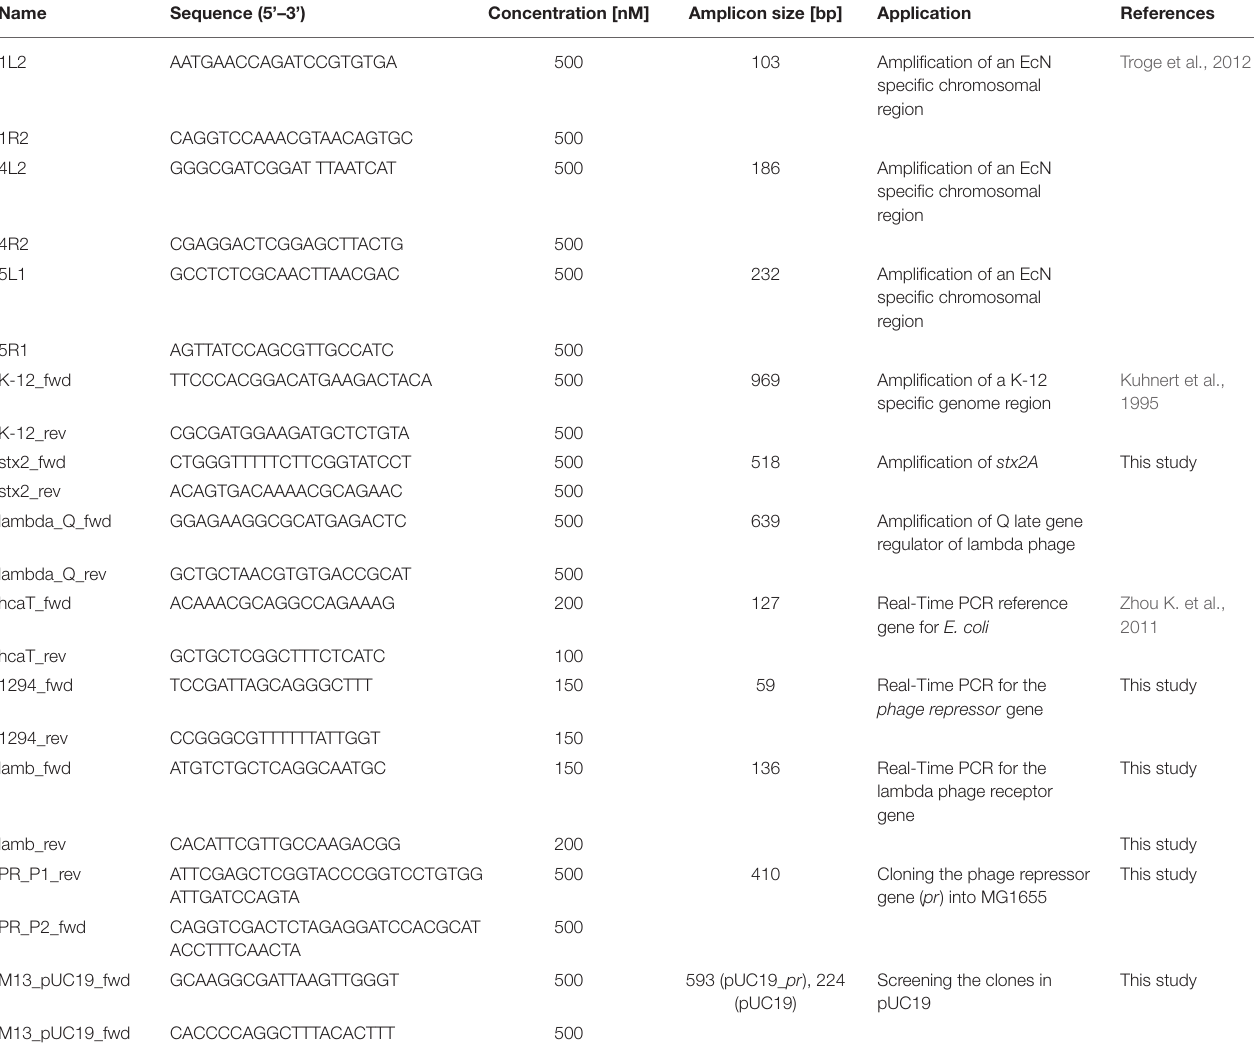
TABLE 2 | Oligonucleotides used in this